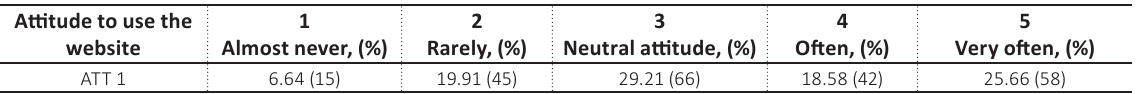
Table 6. Website content quality factor